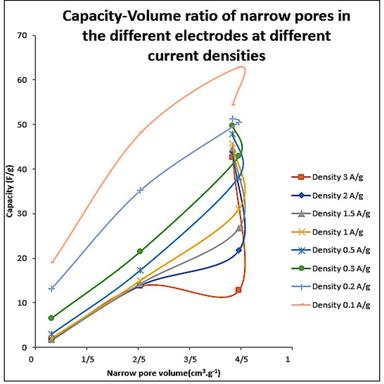
Narrow electrode pore volume vs. supercapacitor capacity.